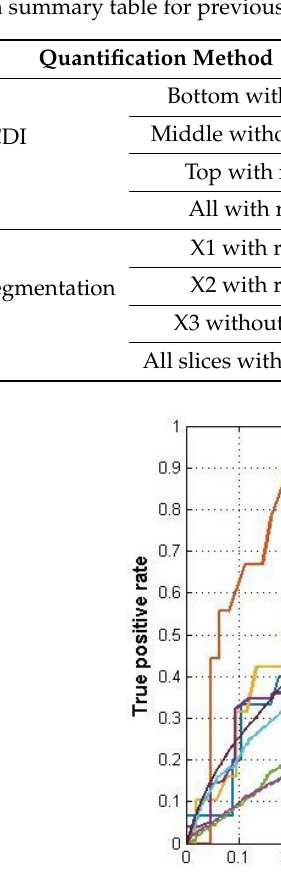
Table 9. Summary of the best performance of CDI and manual segmentation using different feature spaces (a summary table for previous tables).